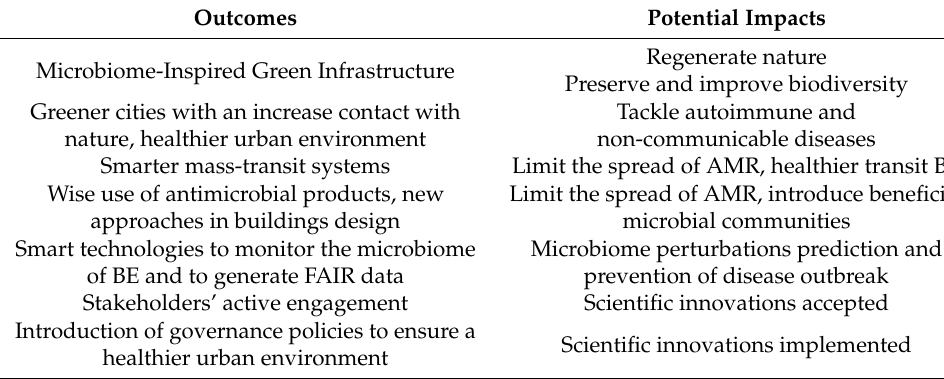
Table 1. Main outcomes and potential impacts of an urban regeneration based on knowledge of the microbiome of built environments. Outcomes Potential Impacts Regenerate nature Microbiome-Inspired Green Infrastructure Preserve and improve biodiversity Greener cities with an increase contact with Tackle autoimmune and nature, healthier urban environment non-communicable diseases Smarter mass-transit